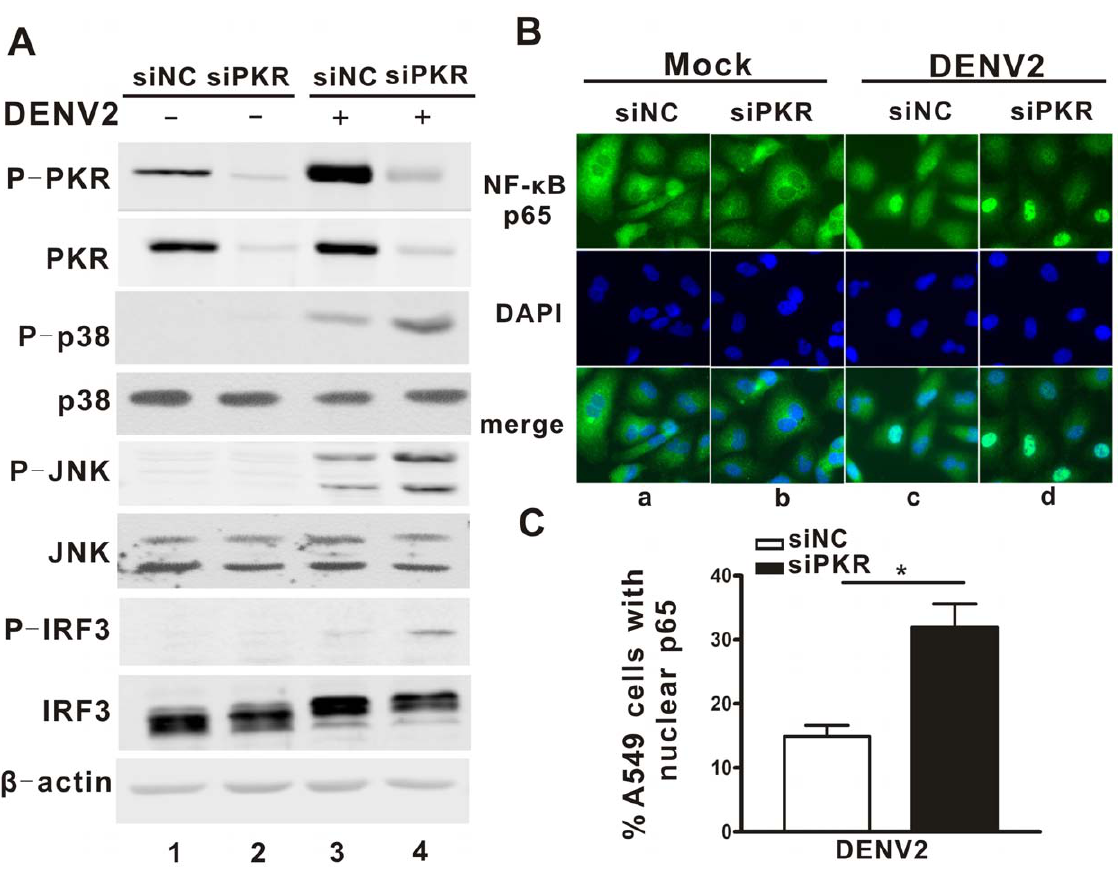
Figure 2. PKR silencing enhanced the activation of p38 and JNK MAPKs, IRF3 and NF- k B. A549 cells were transfected with siPKR1 or siNC followed by infection with DENV2. (A), Western blot to show the phosphorylation form and total protein levels of the MAPKs p38 and JNK, IRF3 and PKR. (B), Immunoflurescence microscopy images showing the subcellular localization of NF- k B p65. (C), PicCnt 100x was used to determine the percentages of cells with nuclear staining for NF- k B. Data are shown as the mean 6 SEM and represent at least three independent experiments. *p , 0.05. cells (Figure 4A, lane 1), while significantly lower PKR expression was observed in the cells transfected with the vector plasmid and siPKR1 (Figure 4A, lane 2). Transfection of the vector plasmid in PKR knockdown cells led to a significantly higher expression of IFN- b in those cells (Figure 4B, hatched bars) than in siNC- transfected cells (Figure 4B, white bars) following DENV2 infection. Complementation with K296R protein significantly reversed the PKR-knockdown-mediated IFN- b induction by 35% (Figure 4B, black bars) compared with vector-transfected cells (Figure 4B, hatched bars) (p =0.036). By contrast, the expression of two other mutant proteins, the K64E or the K64EK296R mutants, had no or minimal effect on the IFN production. These results indicated that the dsRNA binding activity of PKR, but not its catalytic activity, is important for PKR to negatively regulate the IFN production.